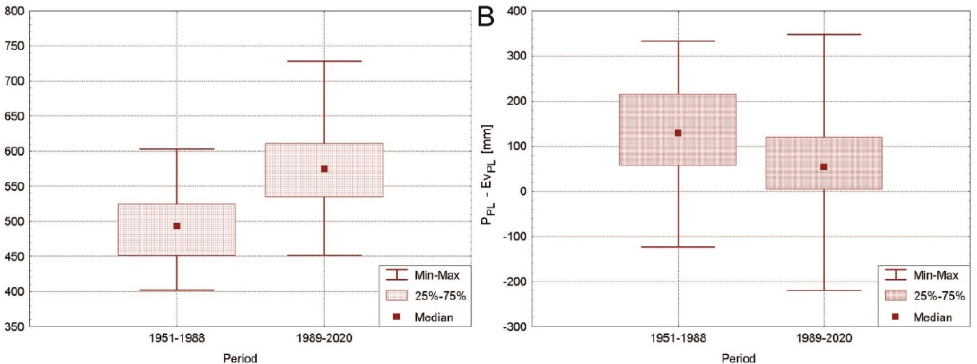
Figure 6. Ranges of variability of the annual area field evaporation (Ev) ( A ) and simplified water balance ( B ) in Poland in sub-periods 1951–1988 and 1989–2020.